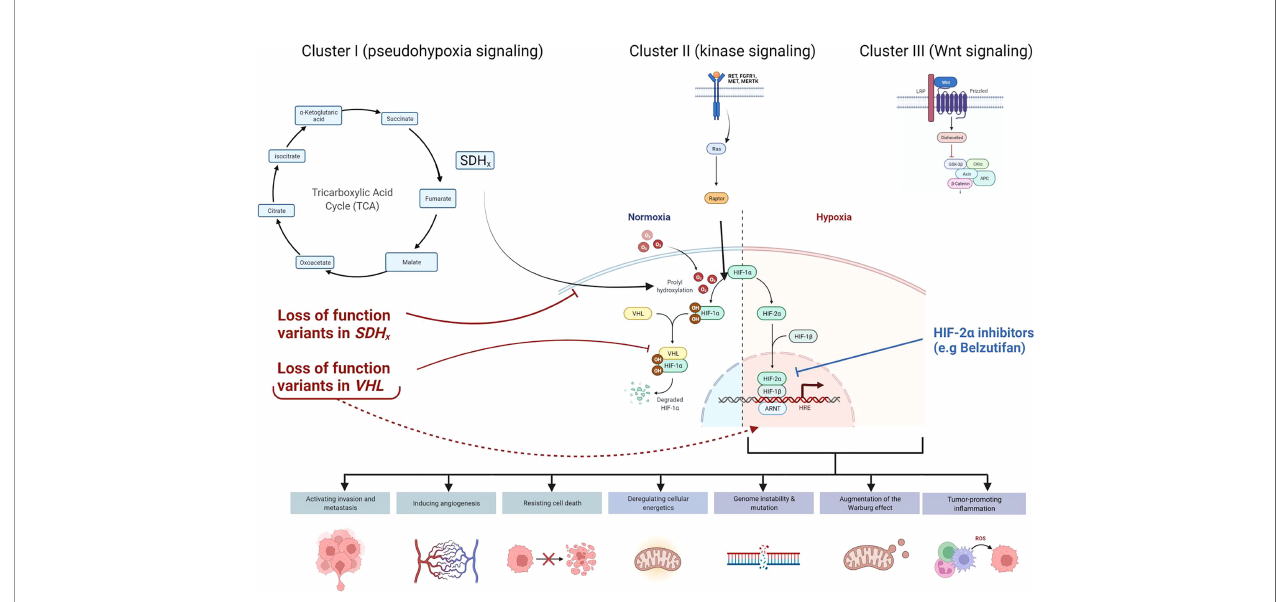
FIGURE 3 | Cellular pathways and genes involved in hereditary paraganglioma-pheochromocytoma (PGL/PCC) syndrome and Von Hippel Lindau (VHL) disease. Approximately 40% of all cases of PGL/PCC cases are associated with germline pathogenic variants in the pseudo-hypoxic signaling pathway (Cluster I), kinase signaling (Cluster II), or Wingless and Int-1 (Wnt) signaling (Cluster III). Pathogenic variants in the SDHx genes ( SDHA, SDHB, SDHC , and SDHD ) and VHL gene are classi fi ed under the Cluster I genes. The SDH complex plays an important role in energy metabolism through the tricarboxylic acid (TCA) cycle. Both VHL and SDHx encode for proteins that target the protein HIF1- a for degradation. Pathogenic loss of function variants in VHL and SDHx genes leads to abnormal accumulation of HIF1- a and upregulation of downstream pathways, which results in increased expression of various proteins and augmentation of the Warburg effect. These negative effects may be mitigated by novel therapies such as HIF2- a inhibitors (e.g